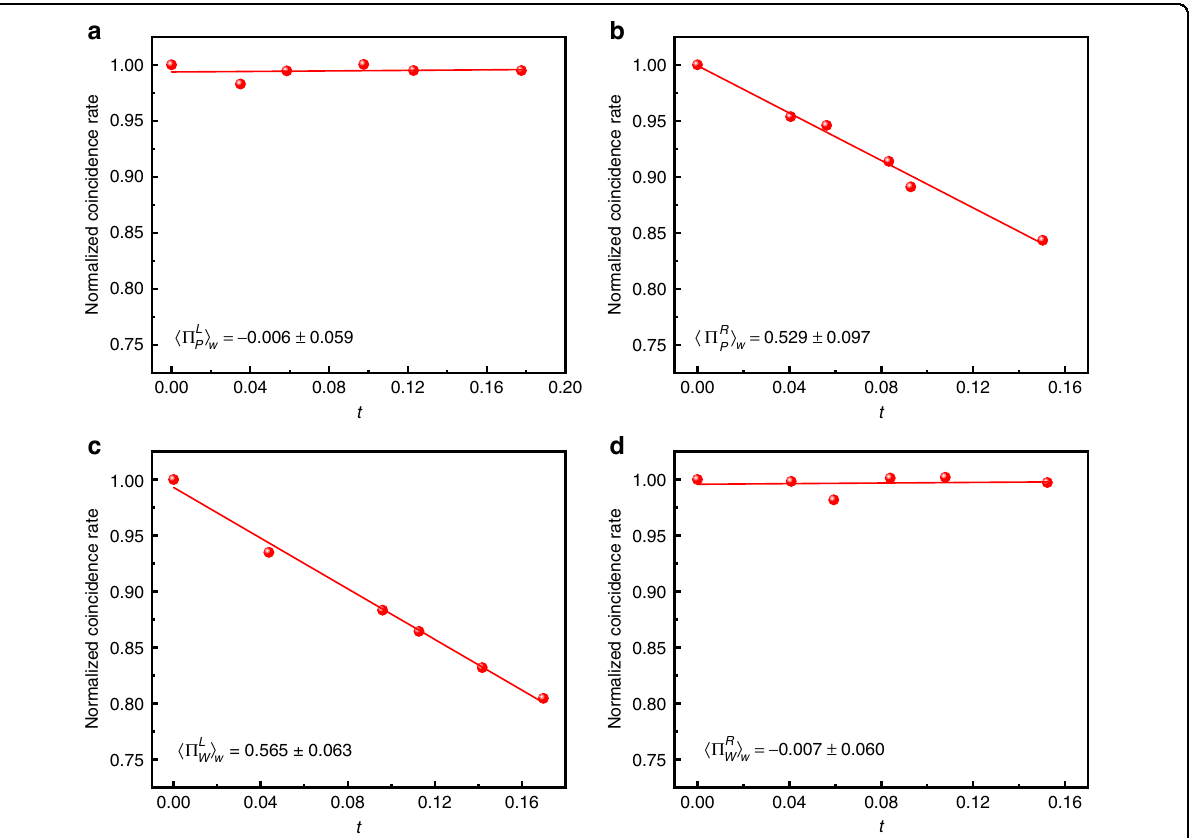
Fig. 3 Experimental data when inserting a series of ND fi lters with different transmission rates for different observables with α ≈ 45°. a – d Points with error bars (overly small to be visible) represent the experimental results and are fi tted with lines for Π L . The corresponding weak value is displayed in the lower-left corner of each fi w